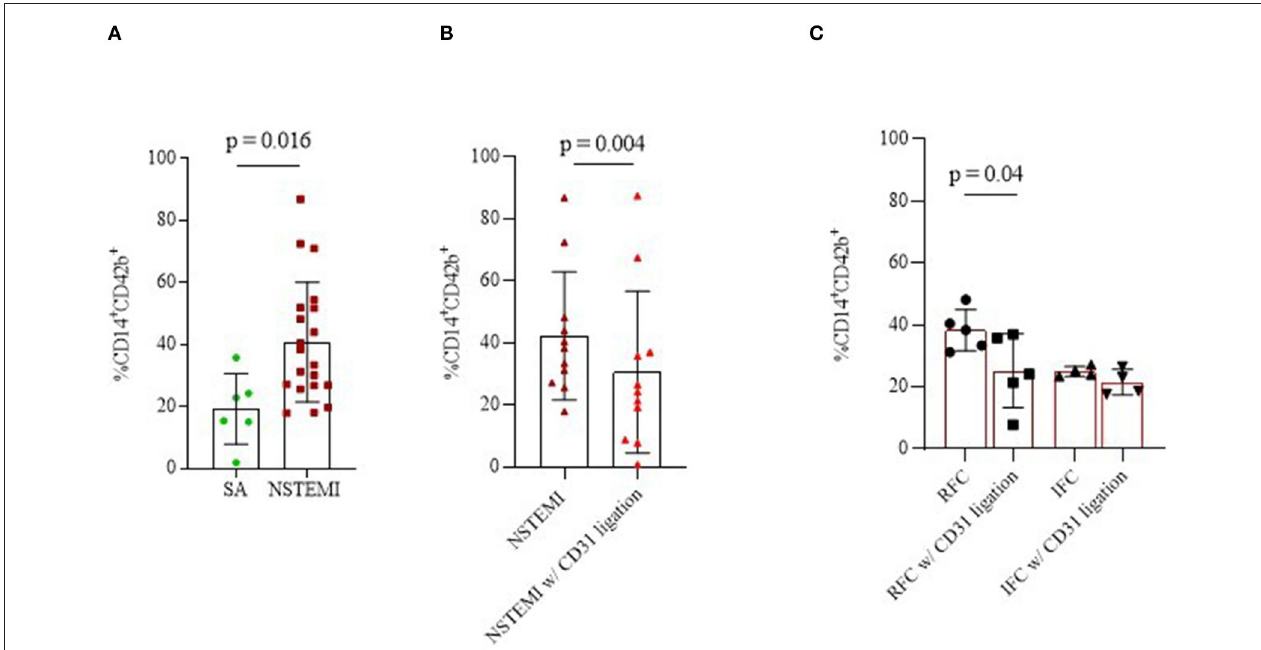
FIGURE 6 | Monocyte-platelet binding. Graphs showing monocyte-platelet (Mo-Plt) binding assessed by flow-cytometry in patients with NSTEMI as compared with patients with SA (A) ; in patients with NSTEMI before and during the CD31 ligation (B) , also according to an OCT investigation (C) . Data are presented as % of